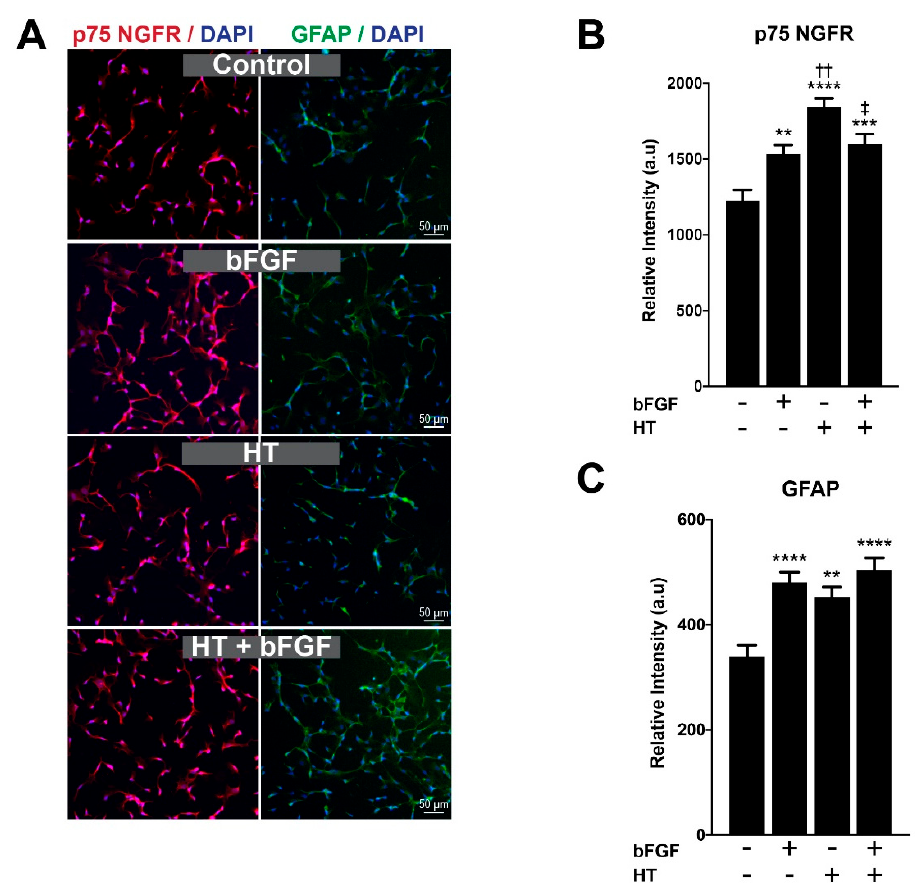
Figure 4. ( A ) Immunostaining of hSC with p 75 NGFR and GFAP. Schwann cells were labelled with p75 NGFR (red) and GFAP (green) in four di ff erent groups. Nuclei were counterstained with DAPI (blue) in all images. ( B ) Expression of p75 NGFR and ( C ) GFAP. Hydroxytyrosol significantly increased the protein expression of p75 NGFR and GFAP compared to control. p -value ** < 0.01, *** < 0.001, **** < 0.0001 vs. control; p -value †† < 0.01 vs. bFGF; p -value ‡ < 0.05 vs. HT. Data were analyzed with one-way ANOVA and post hoc Tukey’s test.